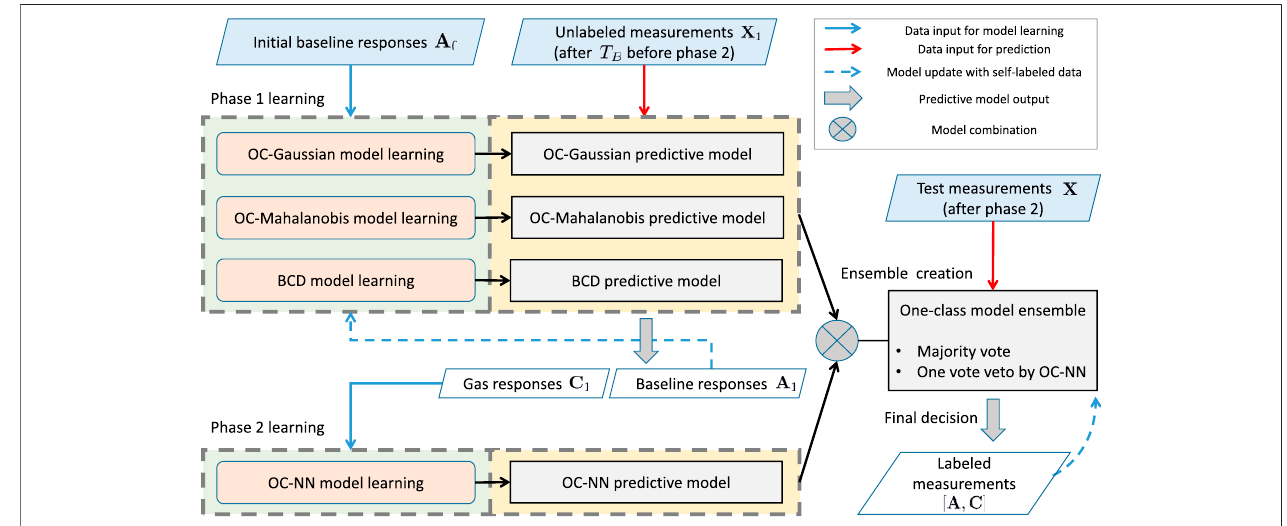
FIGURE 3 | Schematic diagram of the ELBA algorithm. More detailed illustrations for the model learning phase 1 and 2 are in shown Figures 4A,B , respectively. (For interpretation of the references to color in this fi gure legend, please refer to the colour version of this article.)